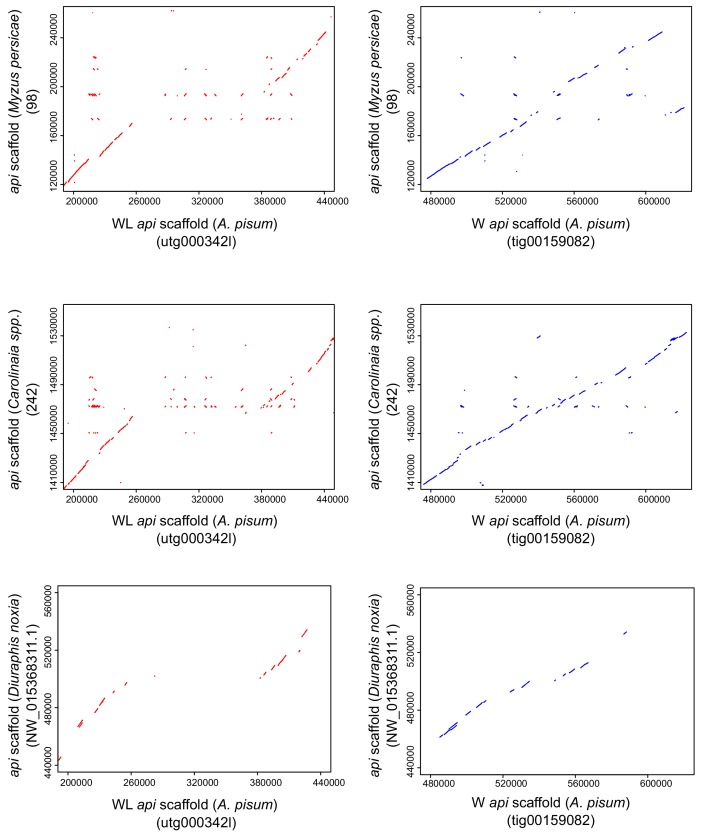
Similarity of the wingless-specific region to putatively homologous regions in the peach-potato aphid (Myzus persicae), the Carolinaia spp. aphid, and the Russian wheat aphid (Diuraphis noxia).Dot plots of the api homologous regions: the pea aphid WL api scaffold compared to the corresponding scaffolds of other aphid species (indicated in parentheses); the pea aphid W api scaffold compared to the corresponding scaffolds of other aphid species (indicated in parentheses).